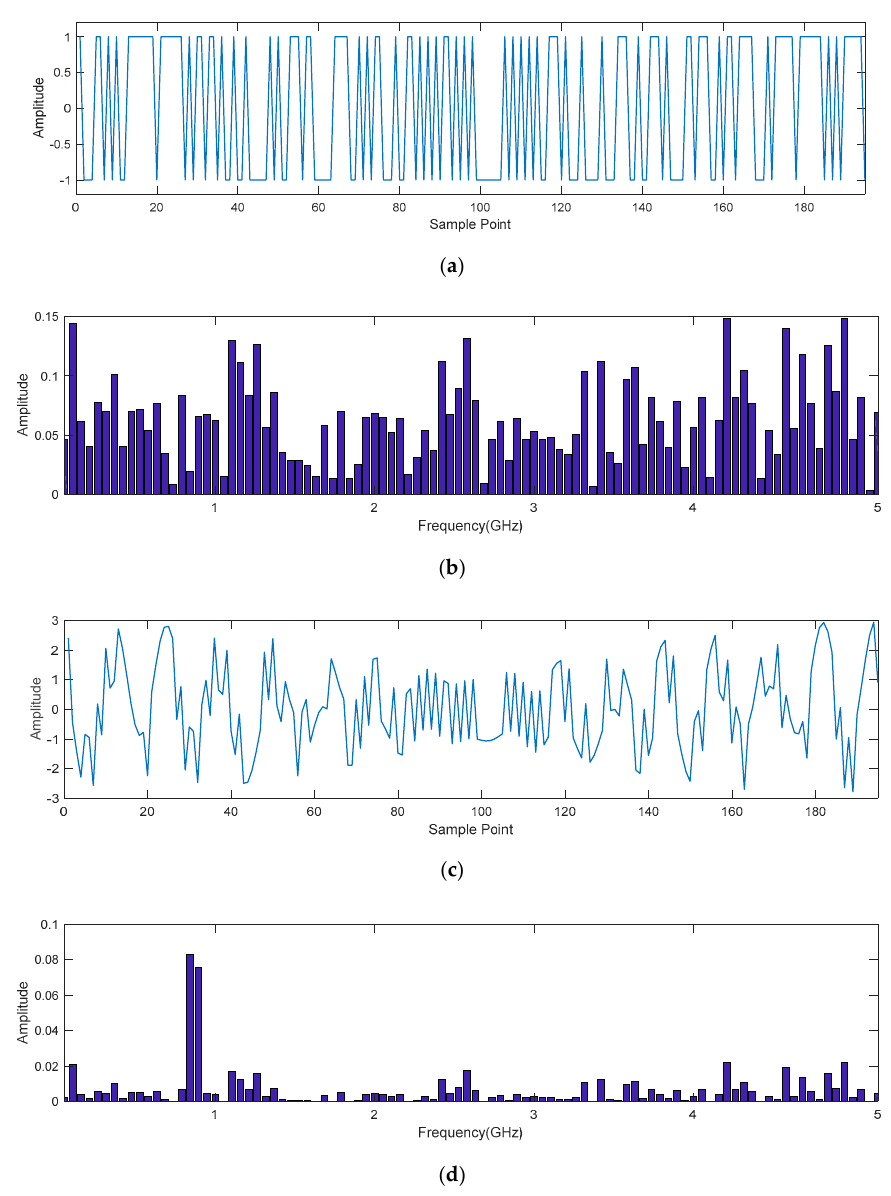
Figure 7. Original periodic function: ( a ) time domain, ( b ) frequency domain and reconstructed periodic function: ( c ) time domain, ( d ) frequency domain.